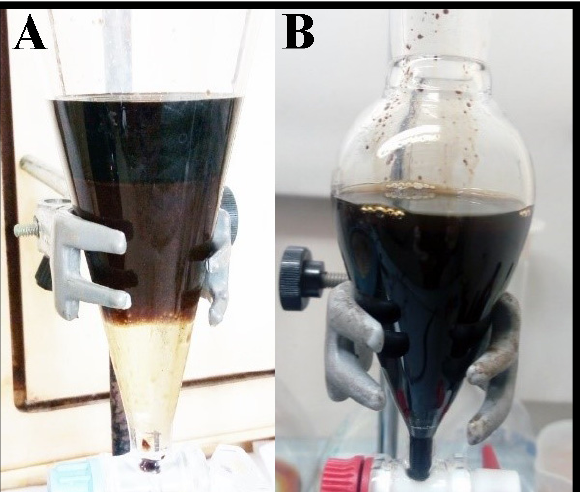
Figure 1. Cork bio-oil emulsions (after a 12 h rest period) from a 50:50 vol.% mix of the bio-oil with ( A ) a 2 M H 2 SO 4 aqueous solution (phase separation) and ( B ) a 2 M KOH aqueous solution.